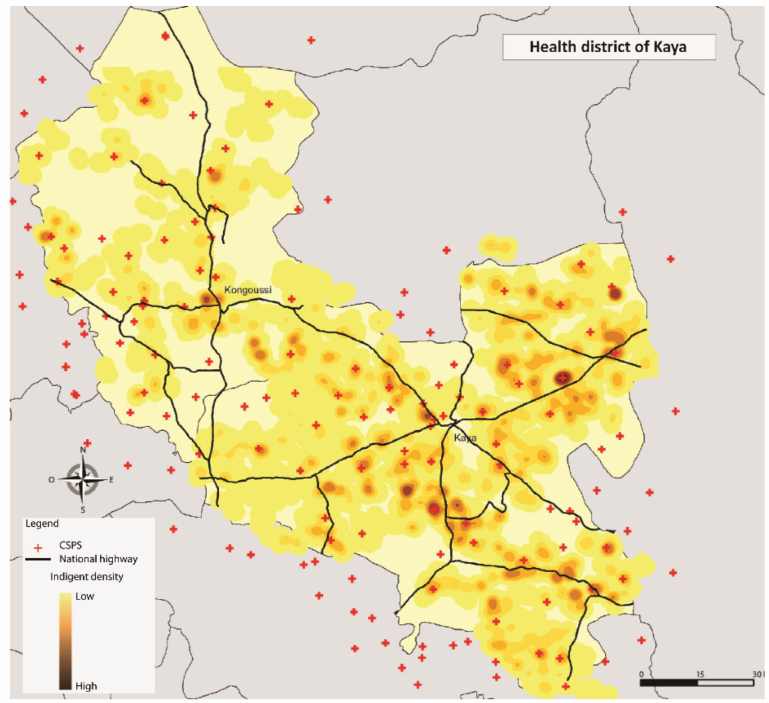
Figure 3. Geographical concentration of the respondents in